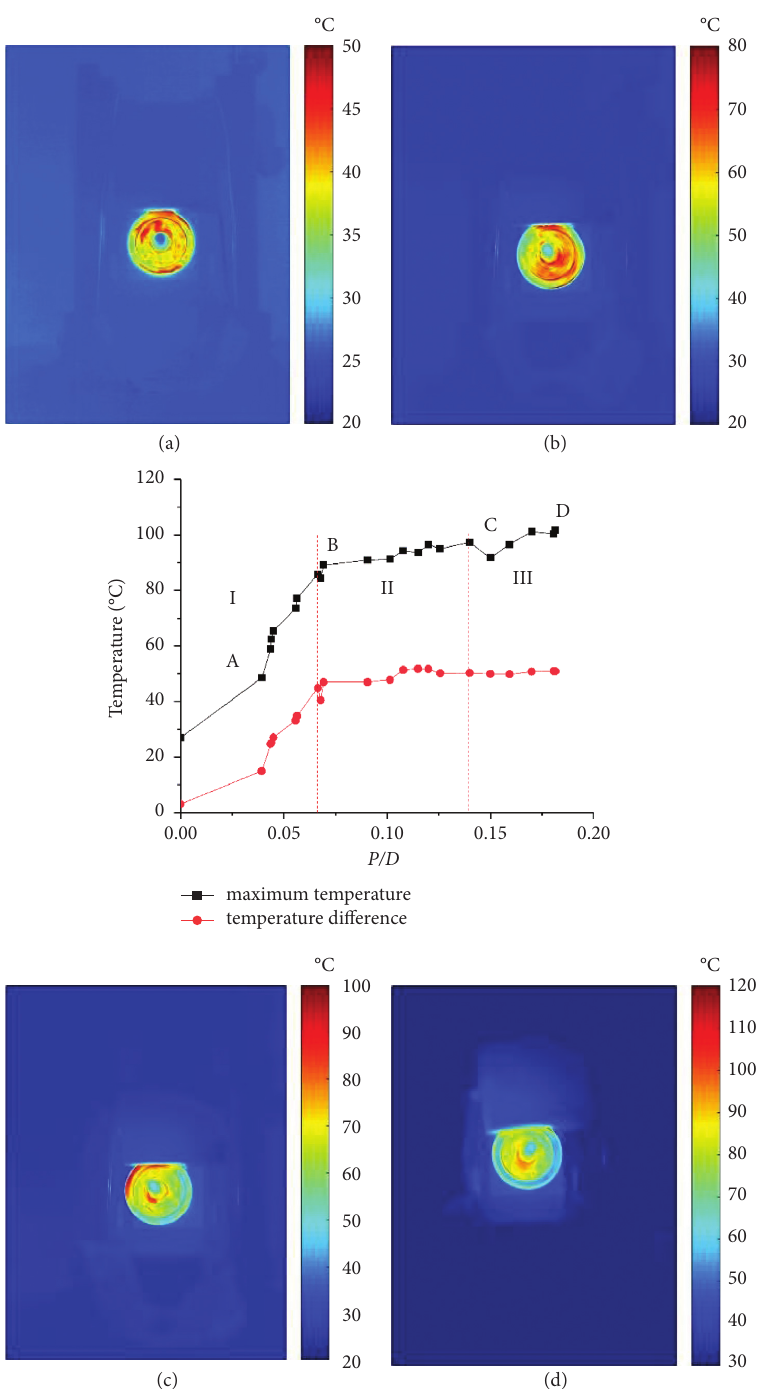
Figure 8: Curves of the maximum temperature and temperature difference on cutter